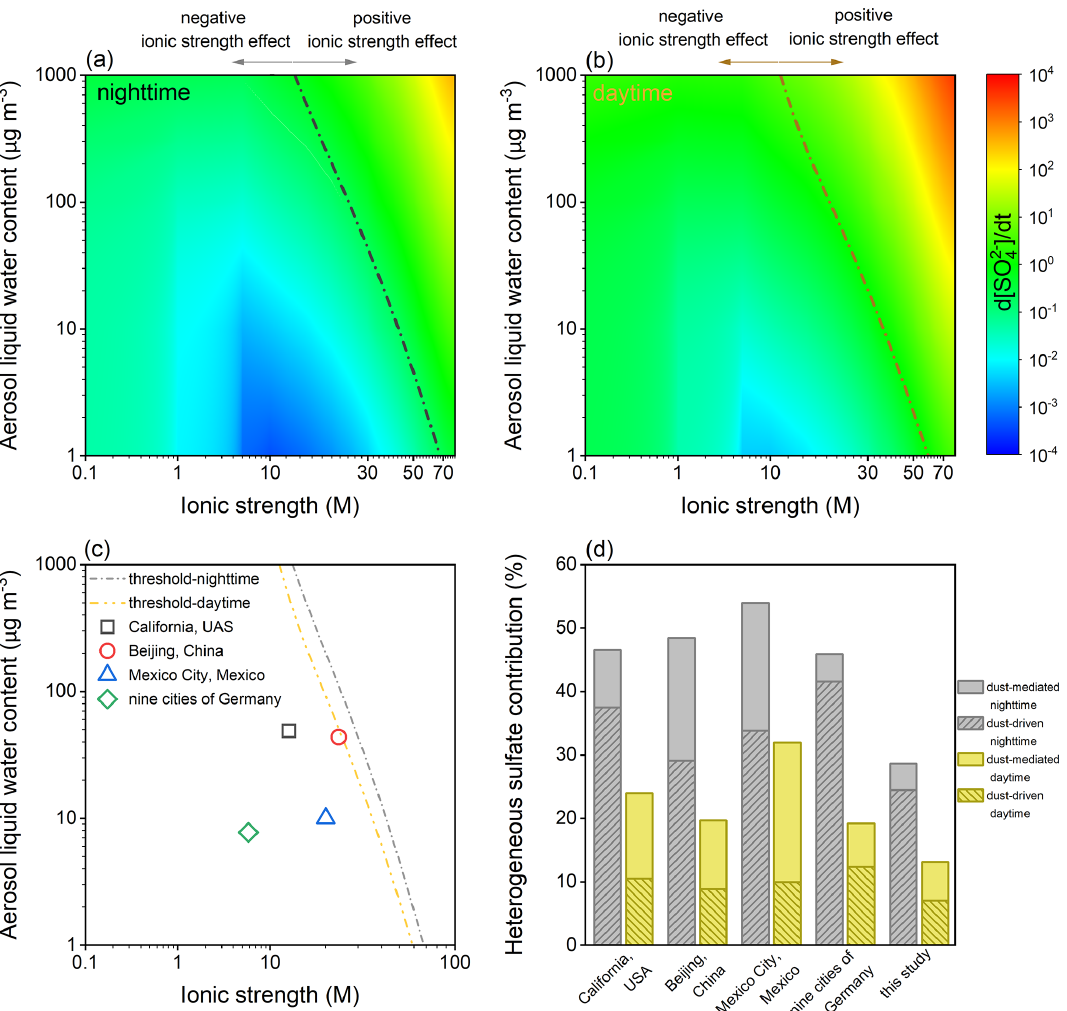
Figure 11. Joint influences of ionic strength (I) and aerosol liquid water content (ALWC) on the aqueous-phase oxidation of SO 2 . Aqueous- phase sulfate formation rate varying with I and ALWC during (a) nighttime and (b) daytime. The dash-dotted lines indicate the thresholds distinguishing the negative and positive effects of ionic strength. (c) Reported I–ALWC relationships versus the nocturnal and diurnal thresh- olds. The field-observed data were collected from the measurements performed in California, USA (Stelson and Seinfeld, 1981), Beijing, China (Song et al., 2021), Mexico City, Mexico (Volkamer et al., 2007; Hennigan et al., 2015), and the nine cities of Germany (Scheinhardt et al., 2013). (d) Heterogeneous contribution proportions calculated by the reported I–ALWC relationships and parameterization of this study (ionic strength-free settings and an ALWC of 300µgm − 3 for aqueous-phase oxidation; dust concentration of 55µgm − 3 for heterogeneous